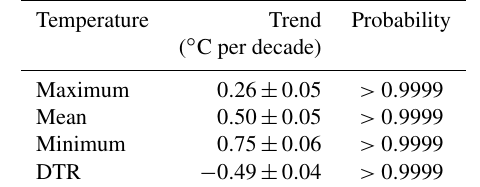
Table 4. Increasing trends in the average annual daily maximum, mean and minimum temperatures and DTR in Hetao for the pe- riod 1958 to 2013.